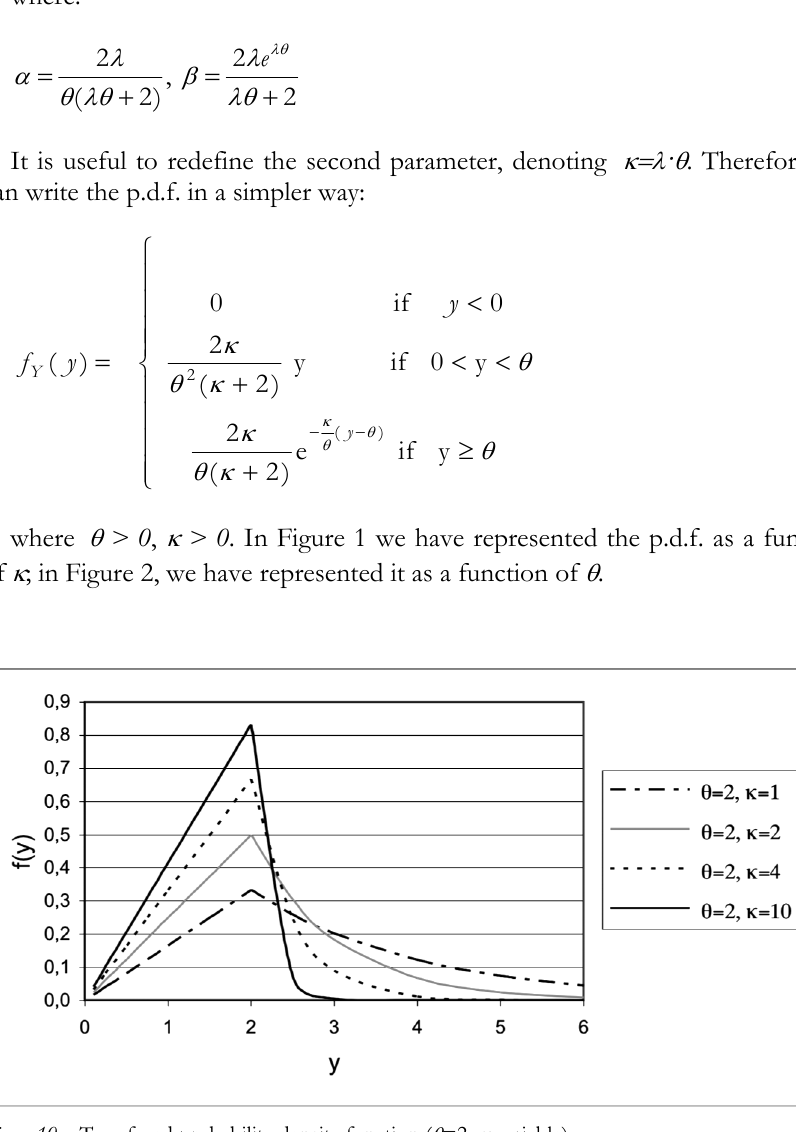
Figure 10 – Two-faced probability density function ( θ =2, κ